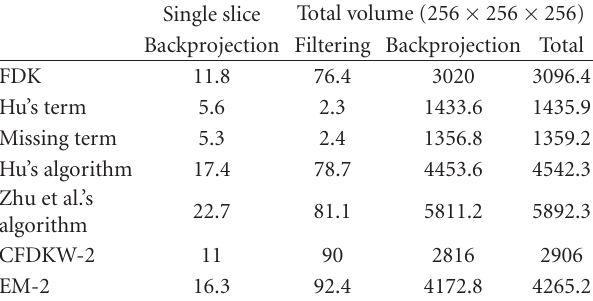
Table 2: Execution time (in